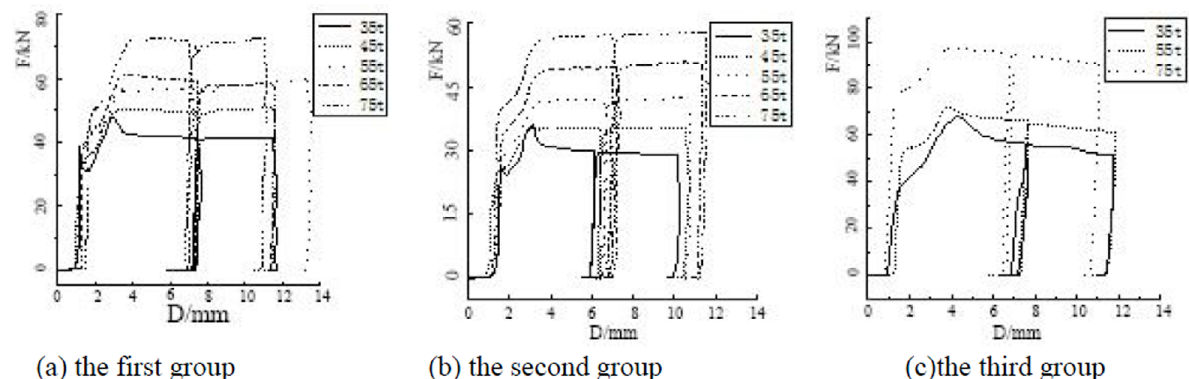
Figure 5. the horizontal force and the displacement curve The first two group of samples had a slim abrasion on the surface of the friction plane as shown in Fig .6.The friction material and the slider were in good